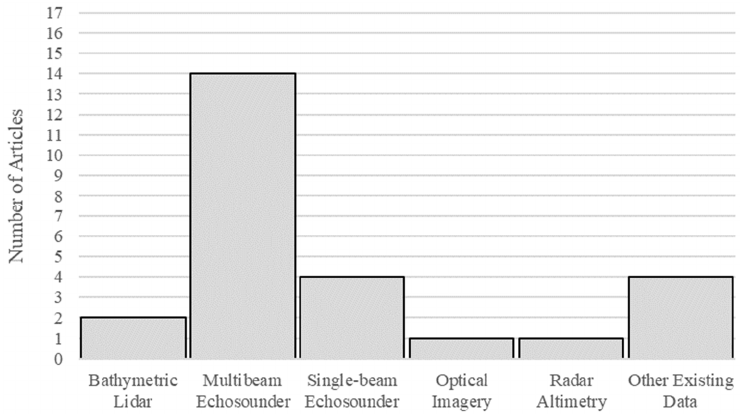
Figure 1. The techniques used in the special issue to sample seafloor depths. Some articles combined multiple techniques. The category ‘other existing data’ includes, for example, navigational charts.